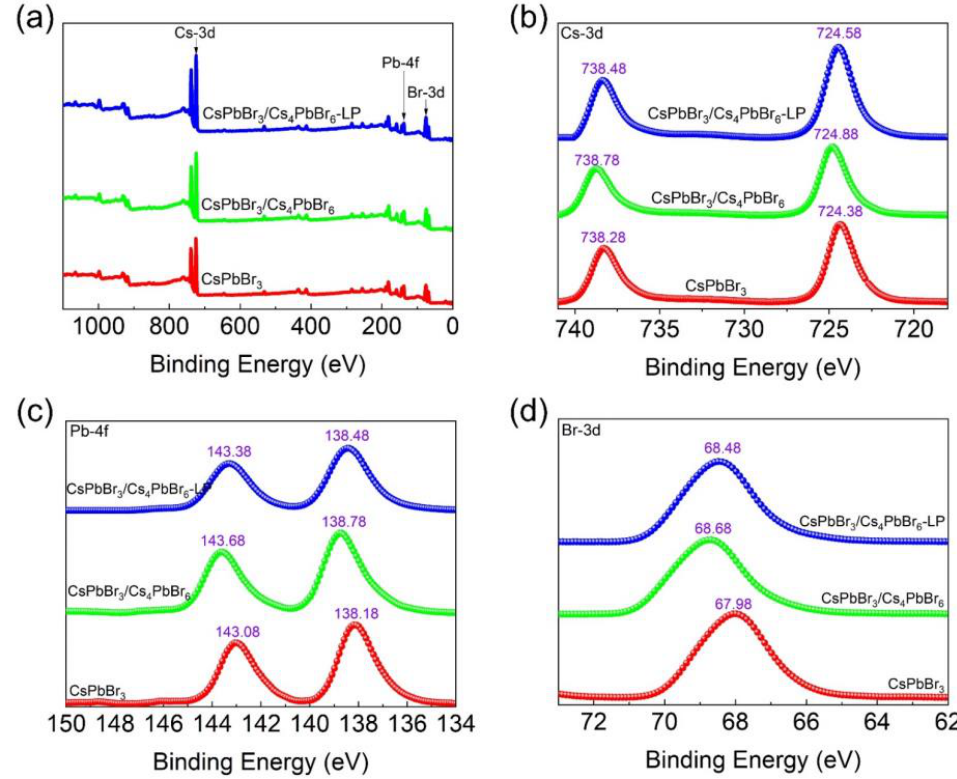
Figure 4. XPS spectra of the CsPbBr 3 /Cs 4 PbBr 6 – LP microcrystals, CsPbBr 3 /Cs 4 PbBr 6 microcrystals, and pure CsPbBr 3 QD powders: ( a ) XPS full spectrum; high-resolution XPS analyses corresponding to ( b ) Cs-3d, ( c ) Pb-4f, and ( d ) Br-3d.